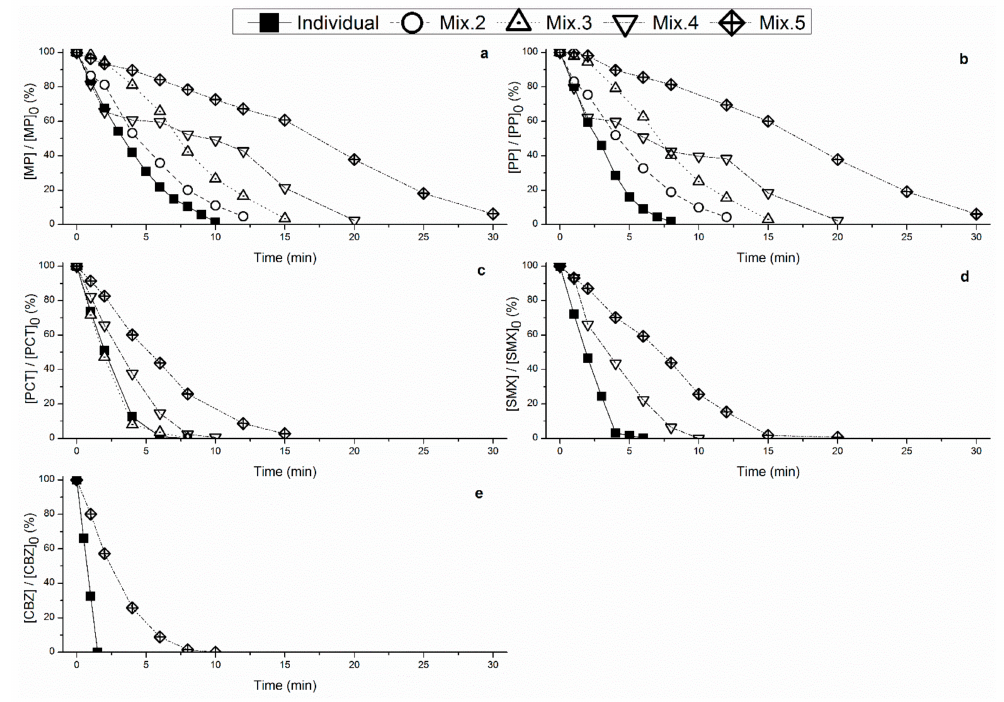
Figure 4. Normalized concentration of MP ( a ), PP ( b ), PCT ( c ), SMX ( d ), CBZ ( e ), during ozonation for the case where individual PPCPs were applied and for different